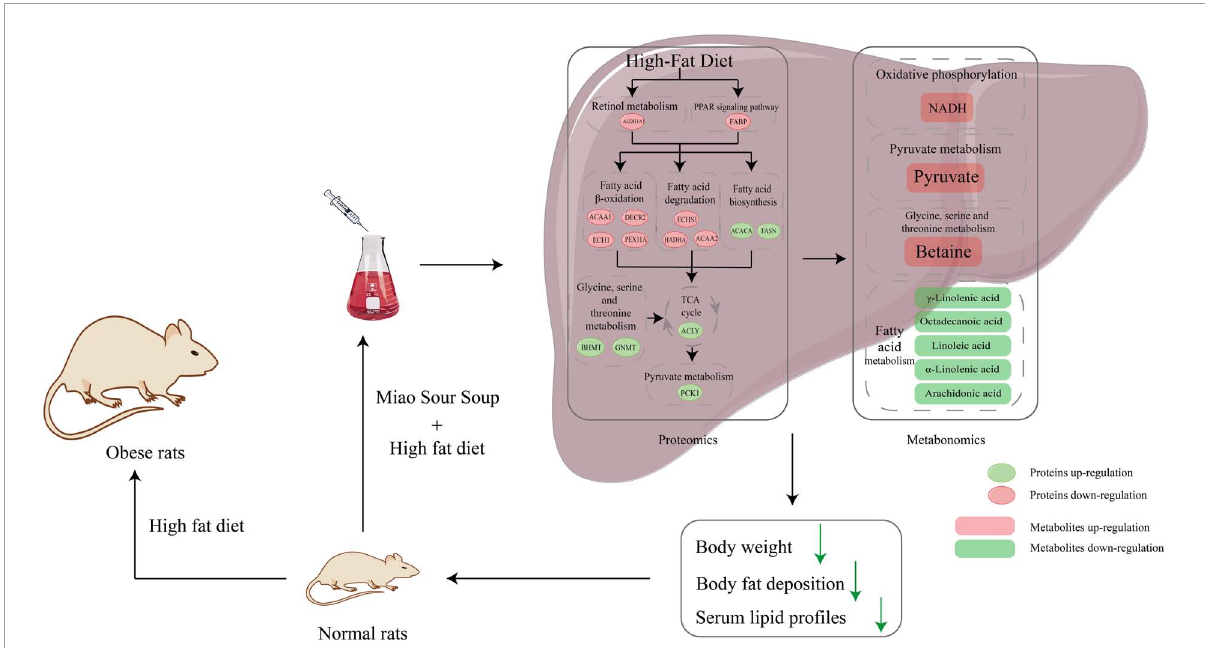
FIGURE6 Schematic diagram of Miao Sour Soup to improve energy metabolism in the liver of HFD-Fed rats. Ellipses indicate proteins and rectangles indicate metabolites, red indicates up-regulation after MSS intervention, green indicates down-regulation after MSS